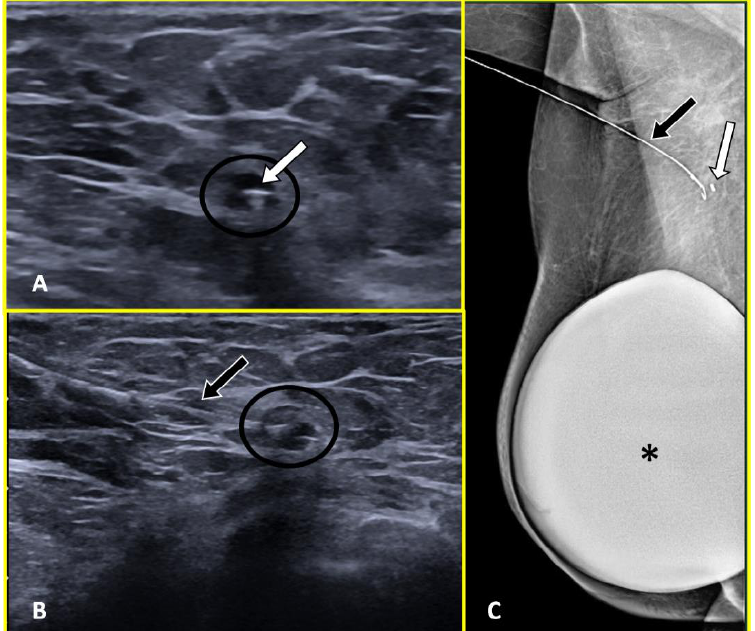
Figure 4. Preoperative wire localization in a 45-year-old woman with right axillary breast cancer recurrence. Ultrasound axial image ( A ) shows the previously positioned marker clip (white arrow) within the pathological node (black circle). Image ( B ) depicts the ultrasound-guided placement of metal wire (black arrow) inside the node (black circle). Post-procedural medio-lateral oblique ( C ) right mammogram demonstrated the correct position of the wire (black arrow) adjacent to the marker clip within the node (white arrow). A breast prosthesis is also visible (asterisk).